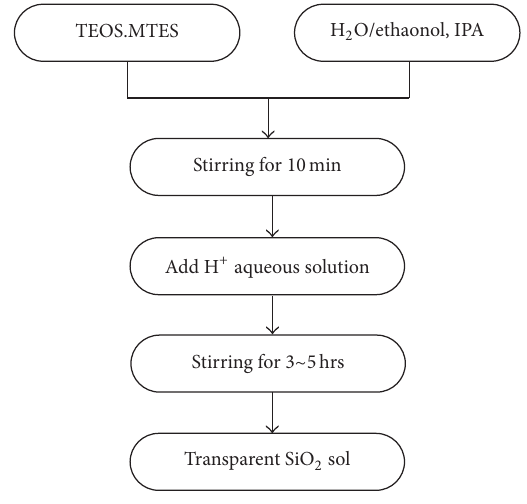
Figure 1: Synthesis of silica sol